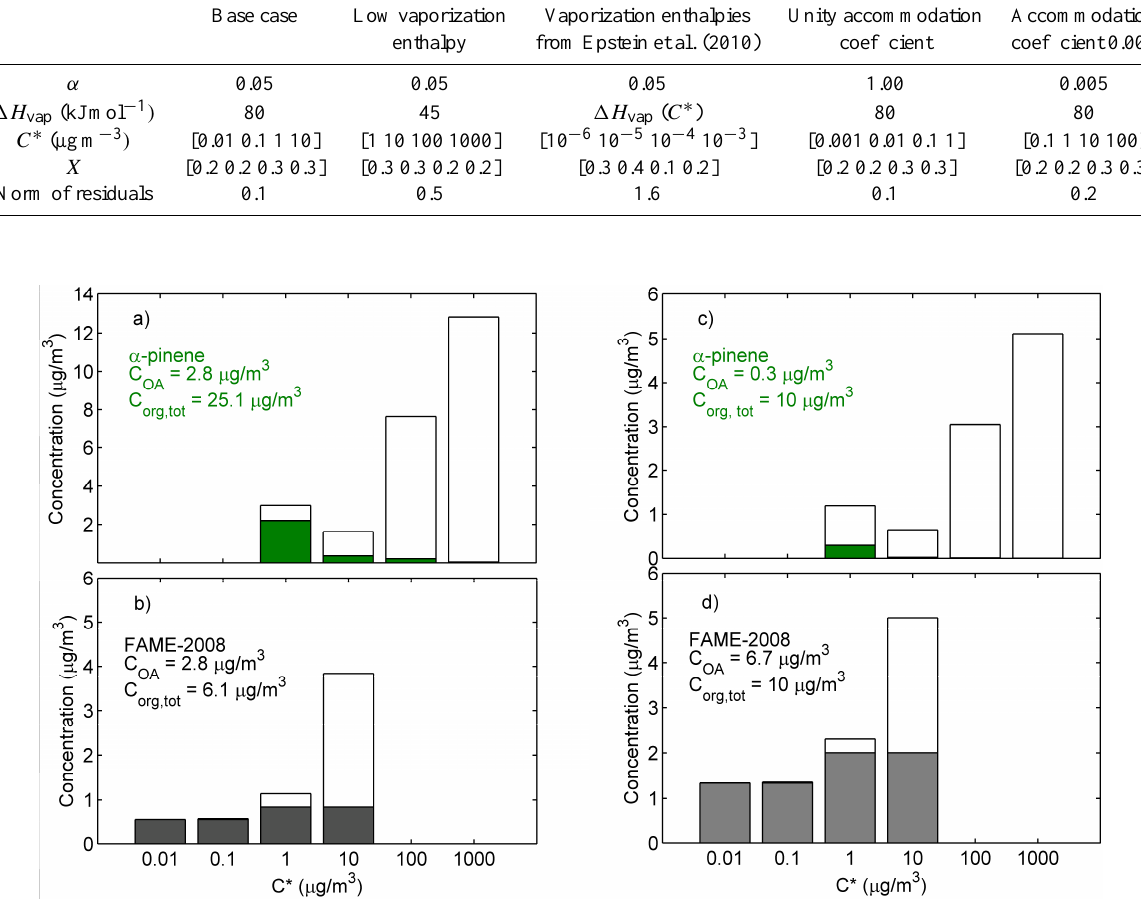
Figure 8. The volatility distributions of aged ambient organic aerosol during FAME-2008 (bottom) for (b) total organic concentration of 10 µg m -3 and (d) total organic aerosol concentration of 2.8 µg m -3 are compared to the corresponding distributions for (a, c) fresh α-pinene SOA (produced in dark, low NO x , and low RH conditions) reported by Pathak et al. (2007).